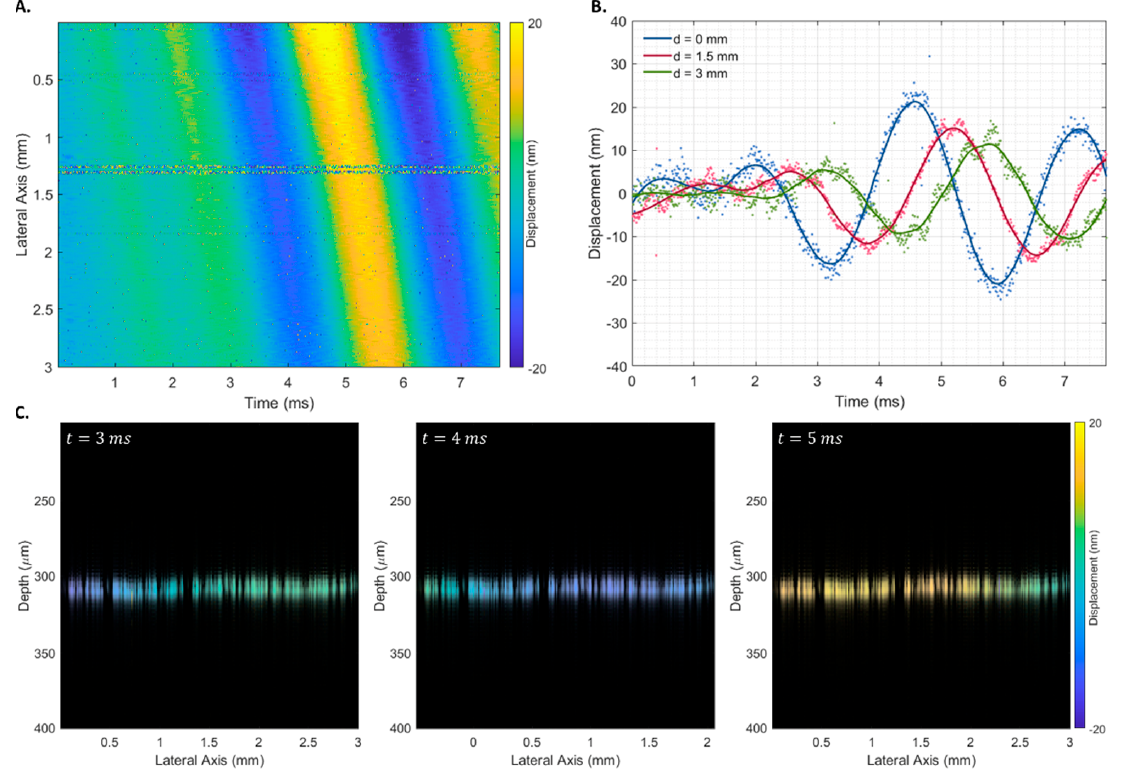
Figure 7. Spatiotemporal displacement map of a 10 g/L homogeneous agarose phantom after a 500 μs transient pulse ( A ), displacement curves at three lateral locations at progressively higher distances from the piezoelectric actuator ( B ), and Rayleigh wave propagation at times 3, 4, and 5 ms ( C ). The phase difference was estimated using the proposed estimator ( ∆ d av